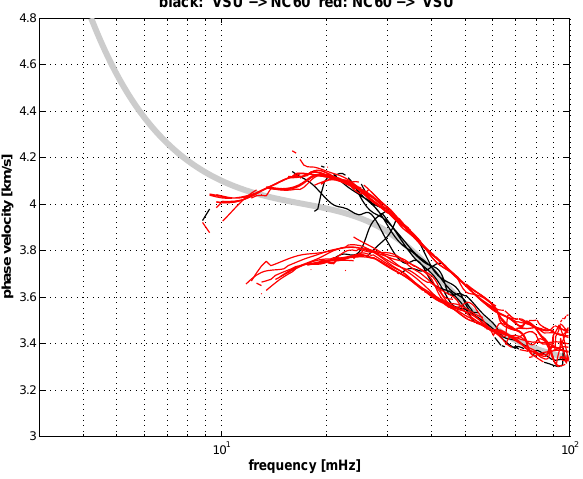
Fig. 2c. Automated phase velocity measurements between station FLT1 in northern Germany and OKC in the eastern Czech Repub- lic. Curves show signature of a response issue with branching offset of measured curves for the two propagation directions. This may reflect differing instrument types but could also point to wrong in- strument